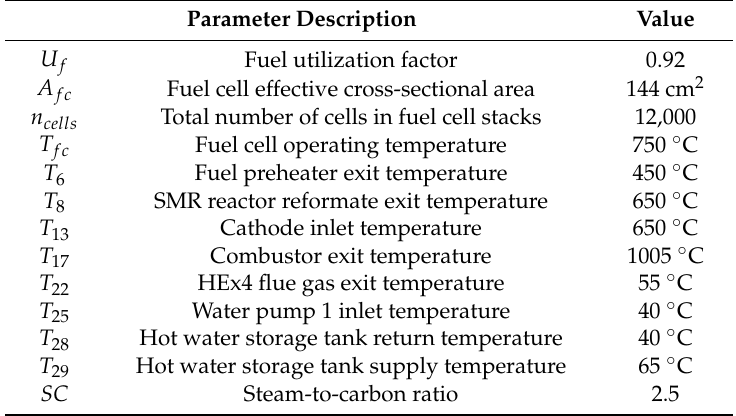
Table 1. System input parameters of the solid oxide fuel cell (SOFC)